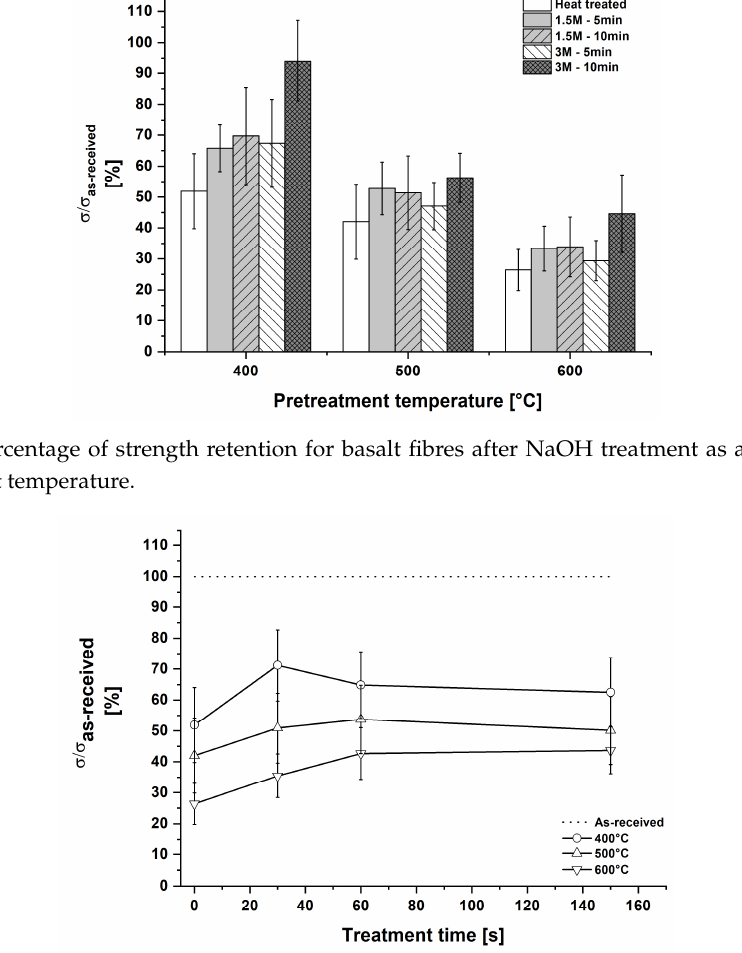
Figure 2. Percentage of strength retention for basalt fibres after HF treatment as a function of treatment time.